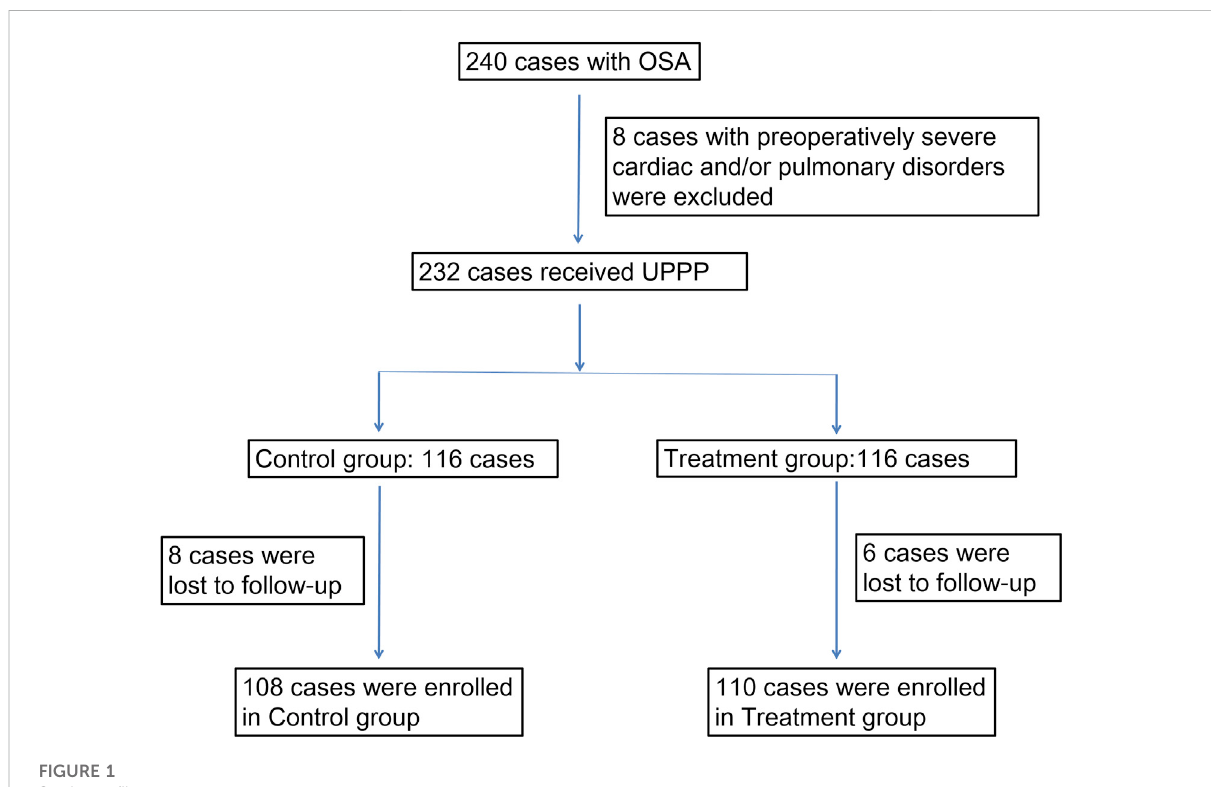
FIGURE 1 Study pro fi